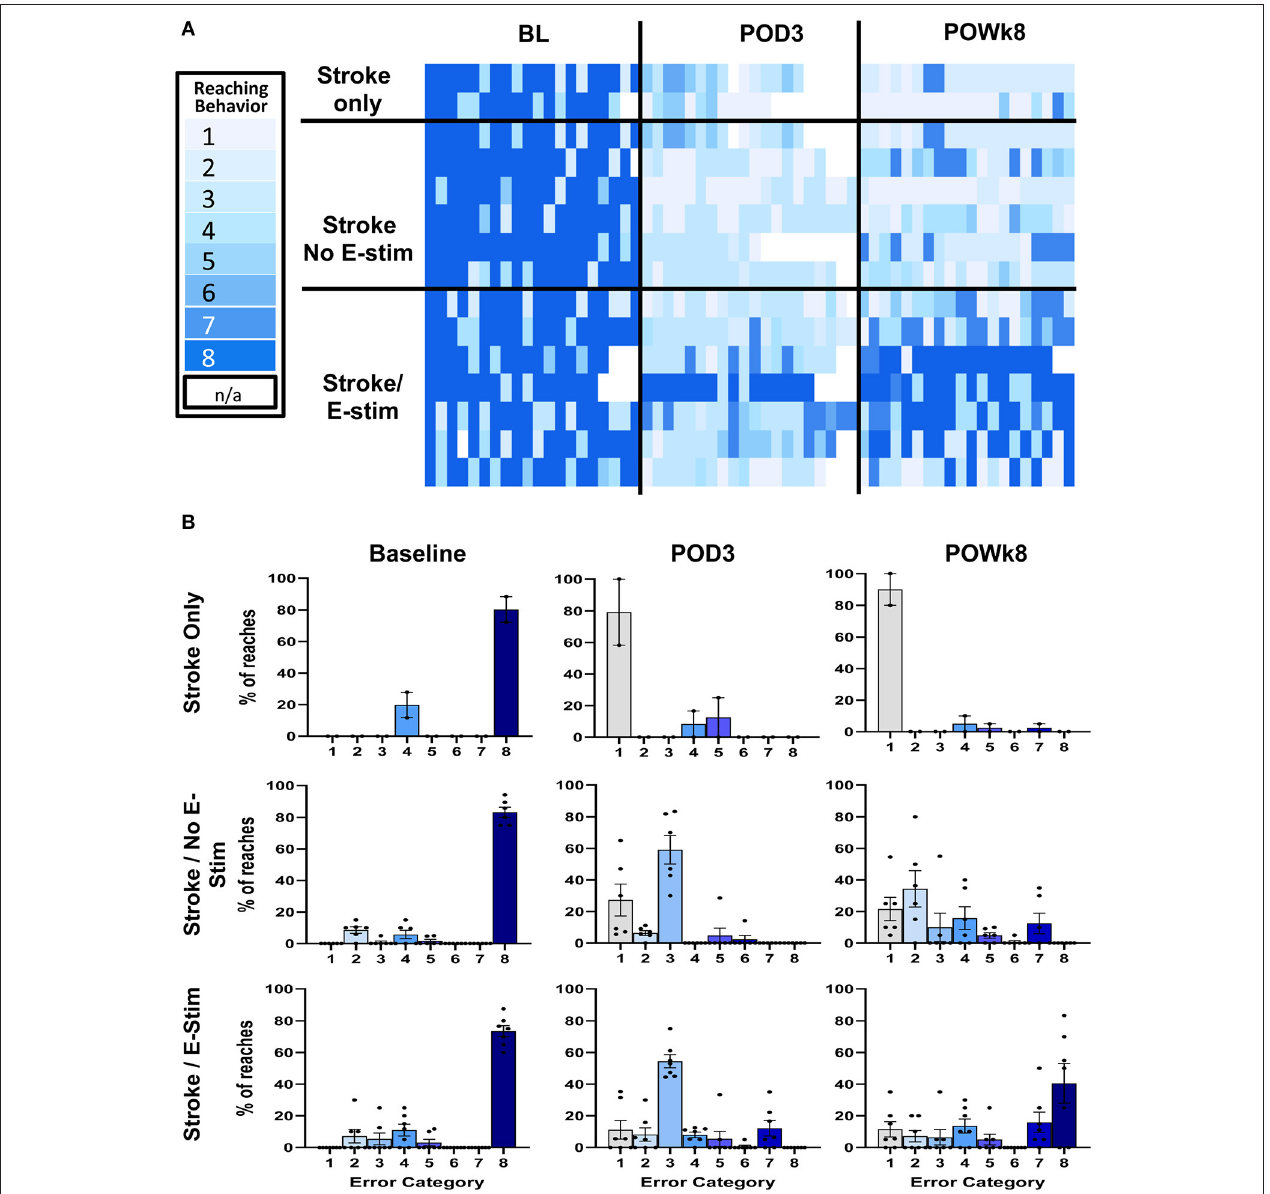
FIGURE 5 | Reaching error analysis. (A) Reaching error analysis of individual animals in each experimental group. All animals’ reaching behaviors were recorded and analyzed at pre-stroke baseline, 3 days post-op before stimulation, and at the end of 8 weeks before BDA injection. The errors were categorized based on reaching error type. Each trial was composed of 20 different reaches where each reach was categorized independently. Reaching behaviors are categorized as follows and range from the lightest blue to the darkest blue: (1) Miss – no extension, (2) Miss – poor aim, (3) Touch –no grasp, (4) Touch – inaccurate grasp, (5) Grasp – dropped early, (6) Grasp – dropped during eating, (7) Success – arm motions not smooth, and (8) Total Success. White boxes represent missing data points (N/A). (B) Bar graph plots of reaching errors. At baseline, most reaches were successes across groups. However, of the unsuccessful reaches, most were in the moderate severity categories. At 3 days post-op (POD3), animals across experimental groups committed errors in the more severe error categories (i.e., 1–3) with less complete success. At the end of behavioral studies (POWk8), animals receiving E-stim not only improved in the number of successful reaches but also committed less errors in the more severe categories. In the non-stimulated groups, animals either showed no improvement (Stroke only) or there was a slightly right shift toward the less severe error categories without increasing success (Stroke/No E-stim).